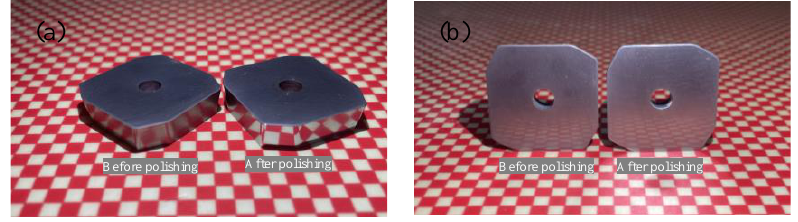
Figure 14. Comparison of cemented carbide insert surface quality before and after polishing: ( a ) flank face, ( b ) rake face.